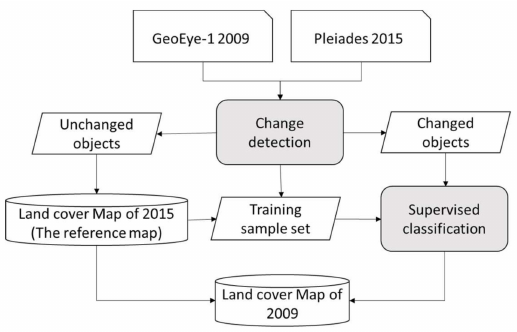
Figure 6. Flowchart of land cover classification integrating of backdating and transfer